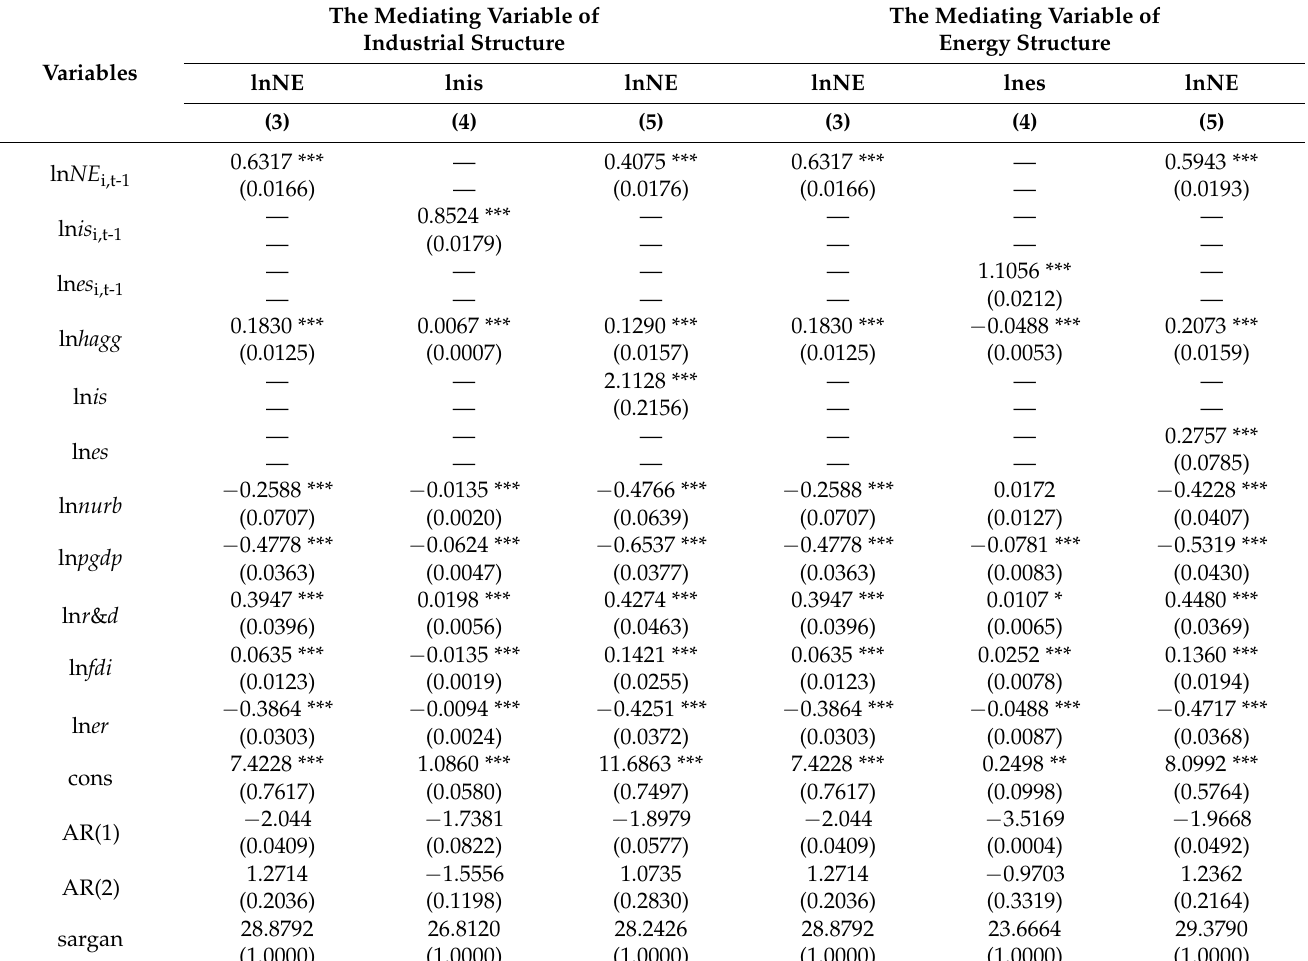
Table 6. Research results on the mechanism of NOx emissions by energy-intensive industries